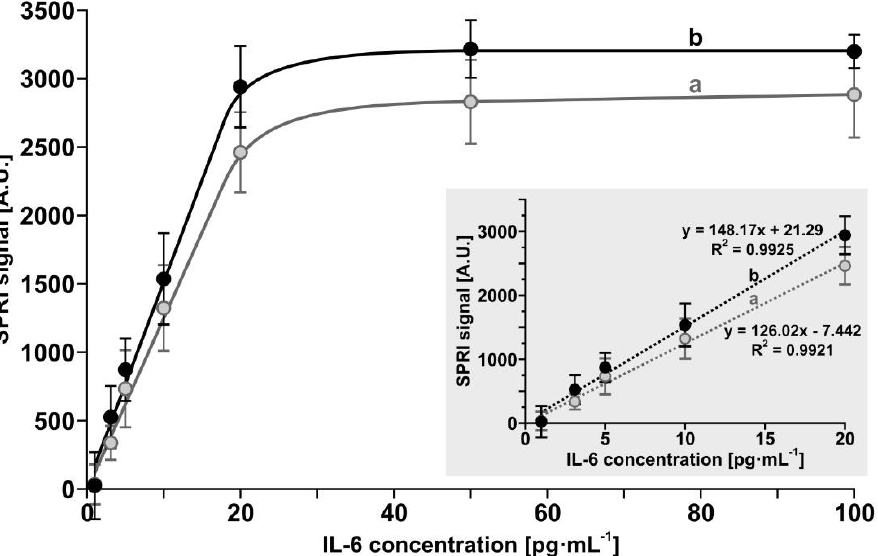
Figure 3. Dependence of the SPRi signal (arbitrary units) on the concentration of IL-6 for the biosensors containing: (a) mouse monoclonal anti-IL-6 antibody, (b) galiellalactone. Error bars (confidence limits) were calculated for 12 independent measurements for each concentration at the 95% confidence level. The inset shows the linearity range.